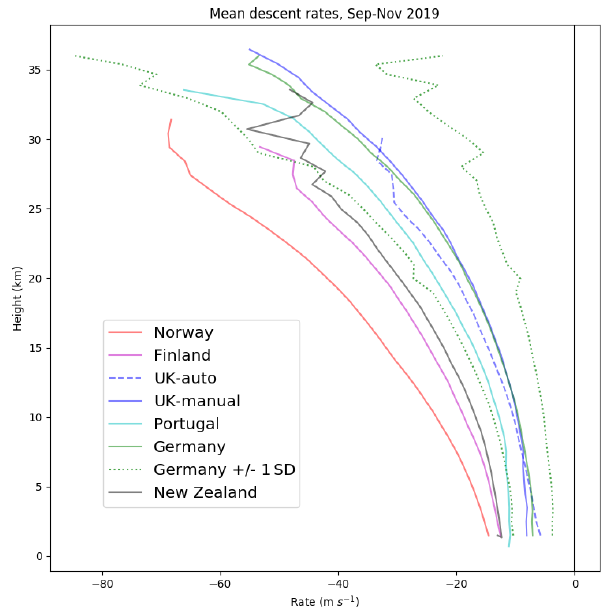
Figure 4. Ascent (grey) and descent (red) rate – an example from Lindenberg (1s data).